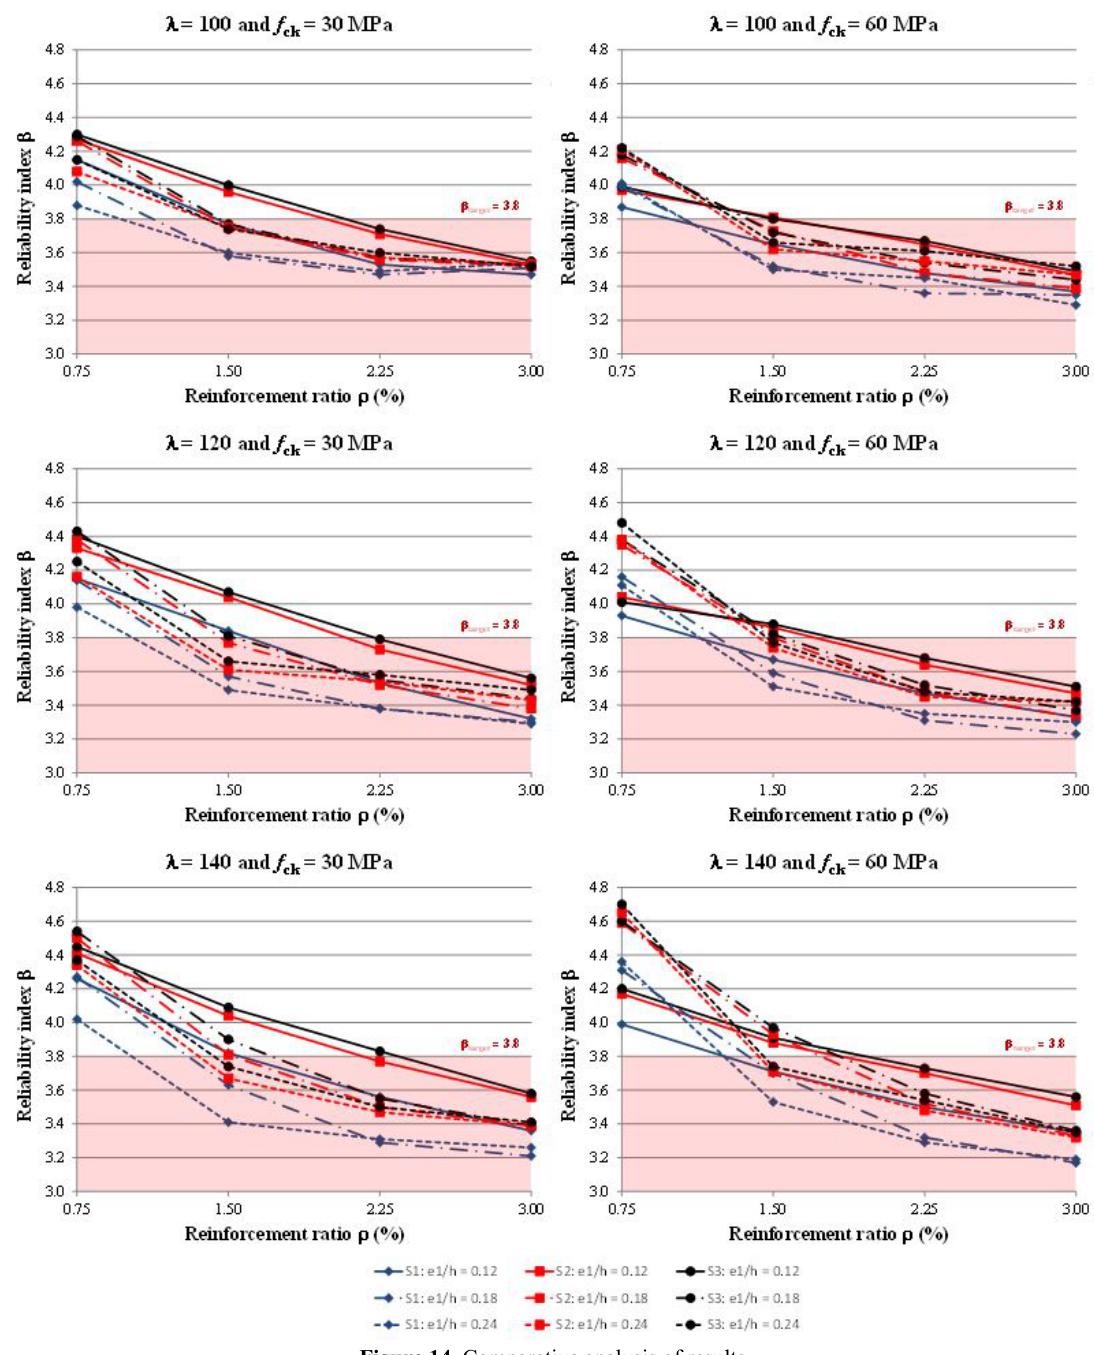
Figure 14. Comparative analysis of